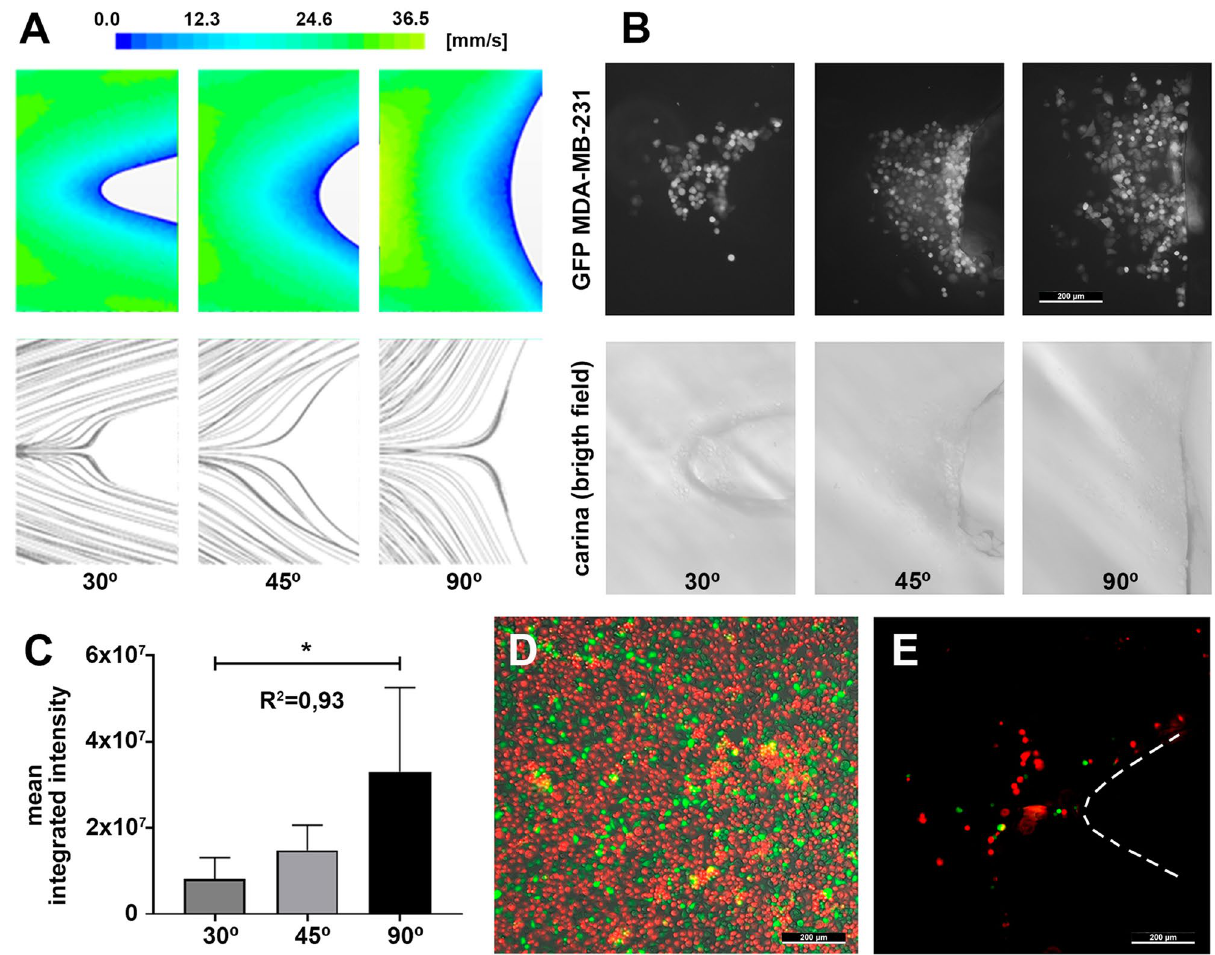
Figure 2. ( A ) Simulations illustrating the distribution of areas of color-coded flow velocities depending on the angle of the bifurcation (30°, 45° and 90°). Note that as the bifurcation angle increases, the area at the carina characterized by an extremely low velocity becomes larger (upper coloured row), and the streamlines followed by the simulated CTC result in larger residence times for each configuration (lower black and white row). ( B ) Representative fluorescence GFP-tagged CTC images (upper row), illustrating the concordant CTC arrest at the carina as the angle of the bifurcation increases as represented in the bright field panels (lower row); the size bar is valid for all the images. ( C ) Quantification of CTC arrest calculated by integrated intensity, is graphically described ( t -test p > 0.05; R 2 = 0.93). ( D ) Representative fluorescence image of red-tagged TIMP1 silenced MDA-MB-231 and green-tagged wild-type TIMP1 MDA-MB-231 cells adhered to the bottom of a plastic well under static conditions, illustrating the improved CTC adhesive properties upon TIMP1 silencing. ( E ) Representative fluorescence image of the red-tagged TIMP1 silenced MDA-MB-231 and green-tagged wild- type TIMP1 MDA-MB-231 cells deposited at the carina of the microchannel after competitive recirculation, illustrating the privileged arrest of the improved adhesive CTC with silenced